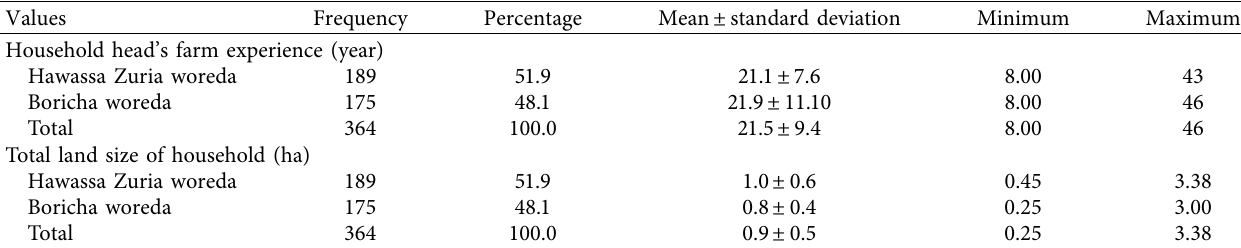
Table 2: Farming experience and land size of households.